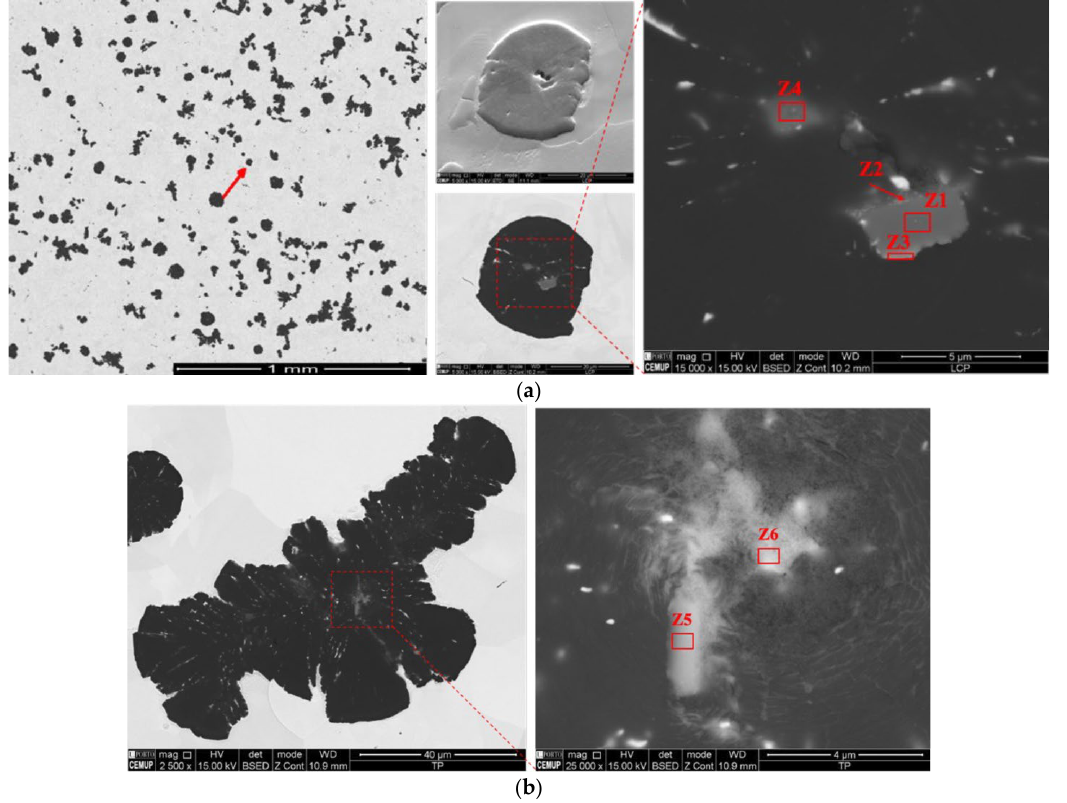
Figure 7. SEM images of ( a ) LCP Un and ( b ) TP Un samples showing complex non-metallic inclusion detected inside graphite nodules.